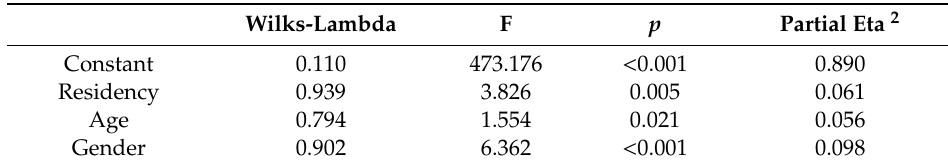
Table 1. Results of a multivariate general linear model with the four attitude subscales as dependent variables. The independent variables were age, gender, and residency. Partial Eta 2 can be understood as the explained